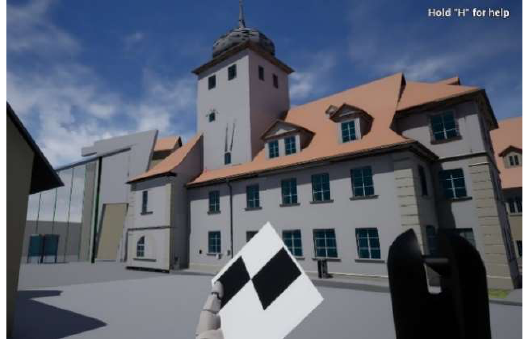
Figure 1: Example of a heritage building as virtual object to be scanned in the 3D terrestrial laser scanner simulator VirScan3D. Visible are the avatars hand holding a checkerboard target and the BLK 3D laser scanner, which will be placed in the selected virtual